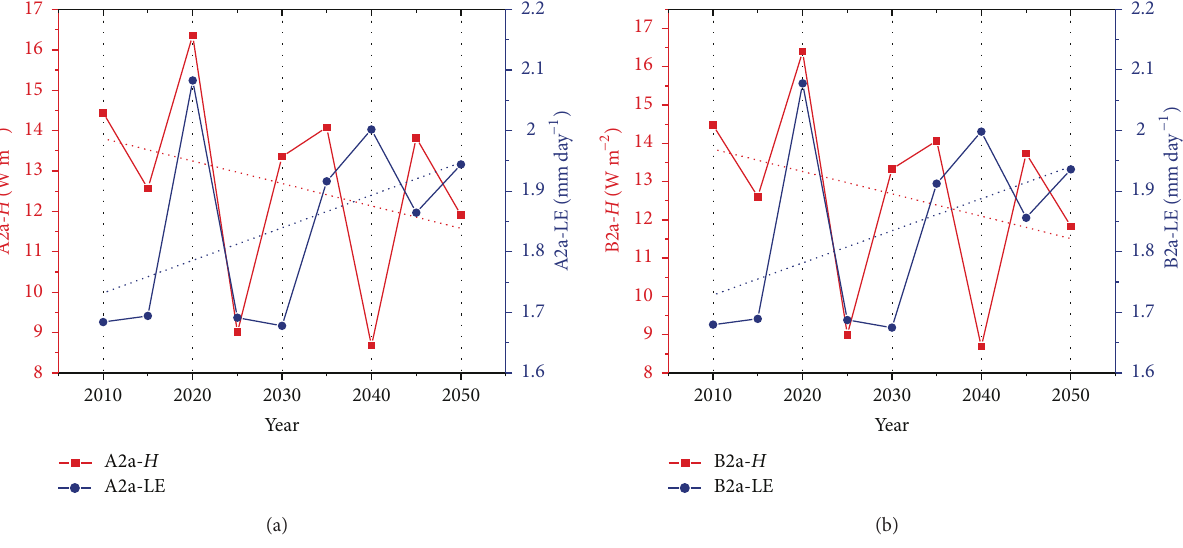
Figure 8: Interannual average areal H and ET in the next 40 years.